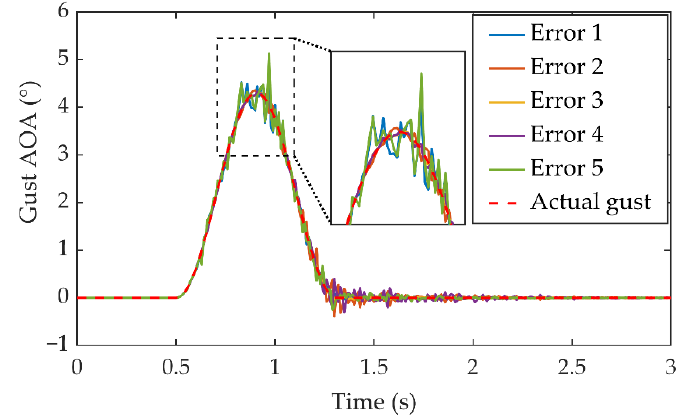
Figure 17. Calculated gust AOA corresponding to different sensor errors.